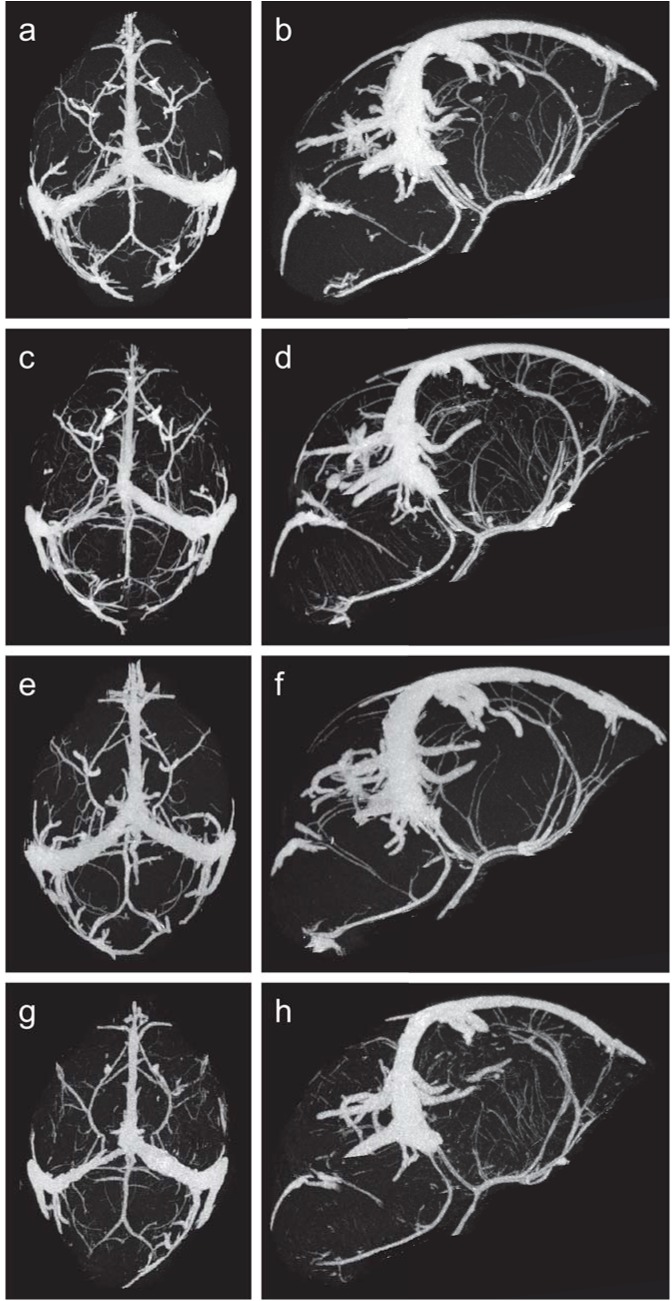
Micro-CT images of fetal cerebral vasculature at gestational day 18.Maximum intensity projection renderings of the axial (a) and sagittal (b) view of vasculature from wild-type unexposed offspring, axial (c) and sagittal (d) view of vasculature from wild-type malaria exposed offspring, axial (e) and sagittal (f) view of vasculature from C5ar-/- unexposed offspring and axial (g) and sagittal (h) view of vasculature from C5ar-/- malaria exposed offspring.